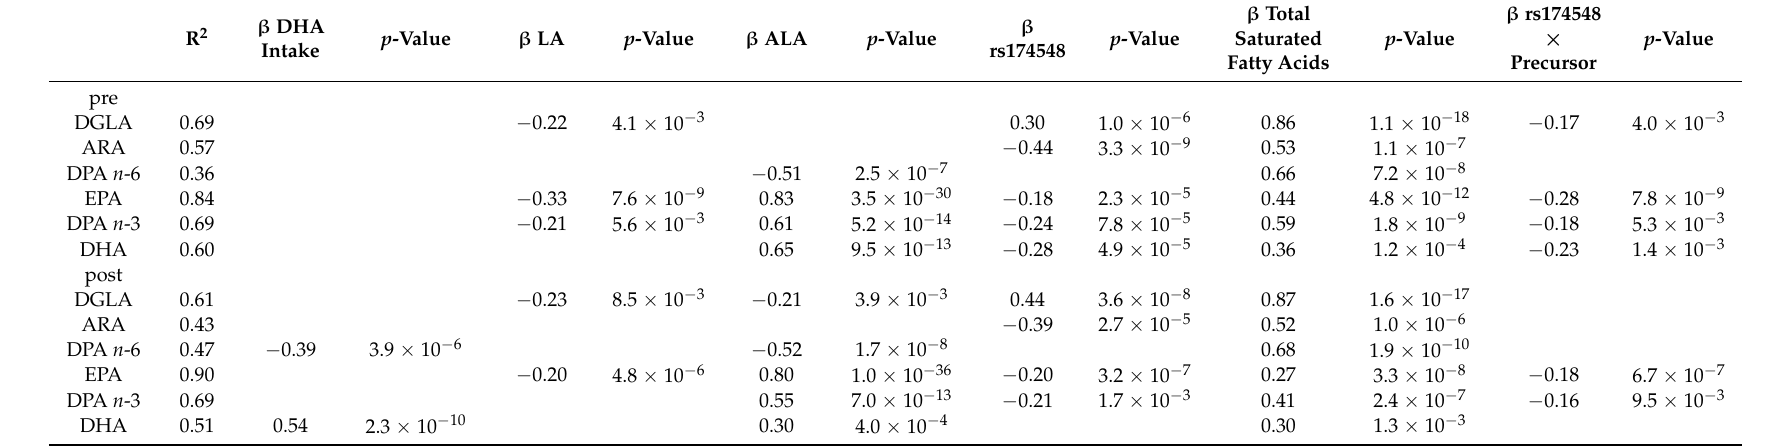
Table 5. Pre and post study associations between essential fatty acid concentrations (LA, ALA), rs174548 genotype, total saturated fatty acid concentration and DHA intake (post intervention only), and major n -3 and n -6 long chain polyunsaturated fatty acid concentrations; only significant ( p < 0.01) standardized β -coefficients are given ( n =